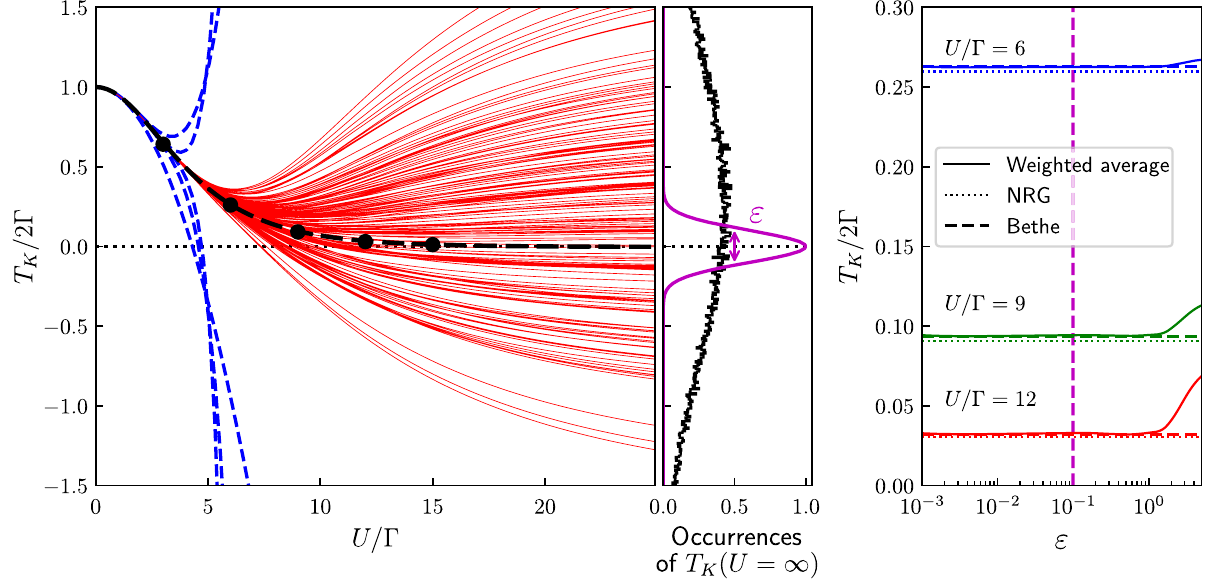
U Þ series by Bayesian inference. Left: Kondo temperature as a function FIG. 6. Reduction of the statistical noise on the resummed T K ð of U . The bundle of red lines corresponds to different samples of our series after resummation (see the text). The thick line shows the final result after Bayesian inference, while the circles show our reference NRG calculations. The dashed blue lines show the bare results U ¼ ∞ Þ obtained from our samples (black without resummation, which diverge for U > 5 Γ . Middle: Histogram of the values of T K ð line) and a histogram of its assumed distribution with tolerance ε (purple line). Right: The final result after inference as a function of ε for three values of U= Γ ¼ 6 , 9, and 12 (thin lines), the reference NRG result (dotted lines), and the Bethe ansatz result (dashed horizontal